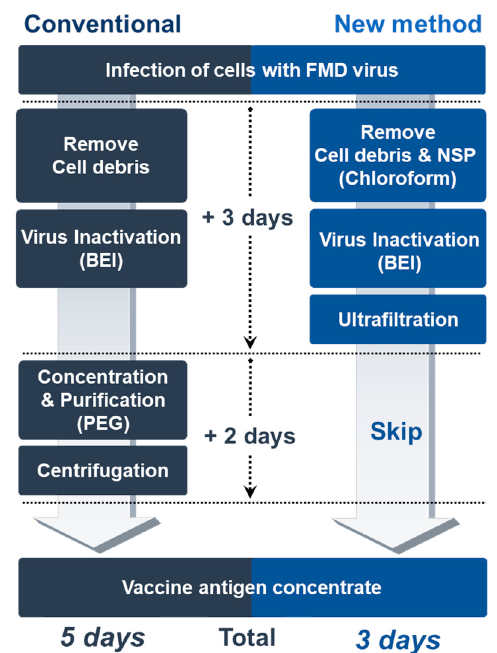
Figure 4. The diagram of FMD vaccine antigen manufacturing process utilizing conventional and new methods. The dotted arrows indicate the turnaround time for the production of FMD vaccine antigen concentrates.